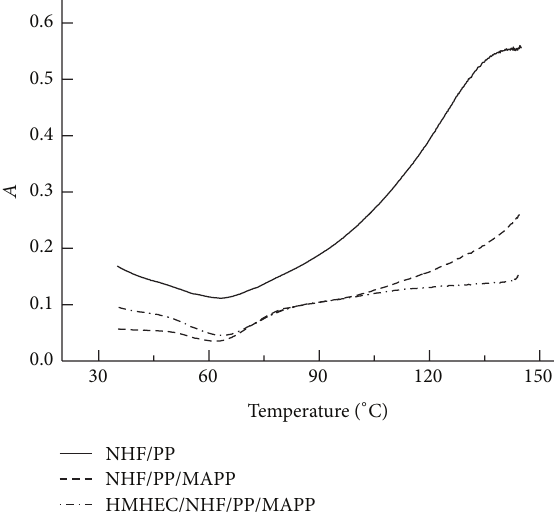
Figure 7: Adhesion factor of different